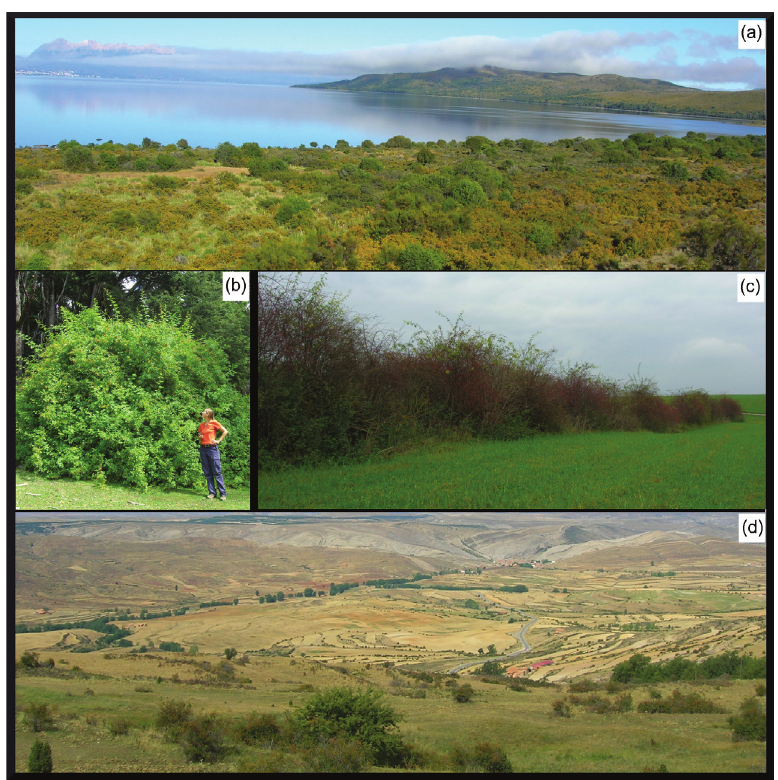
Figure 3. Invasive Rosa rubiginosa populations in Argentina (a, b) and native populations in Germany (c) and Spain (d). In parts of Argentina, single disturbance events have offered windows of opportunity for the species to establish populations, some of which have remained undisturbed for 30 years or longer ( a ) 33,39 . The low level of human landscape maintenance means that populations can expand over vast areas and consist of hundreds of individuals ( a , here along the whole visible lakeside in Patagonia). ( a ) For our study area in Patagonia we predicted that 36% of the area (5000 km 2 ) was threatened by R. rubiginosa invasion, across a precipitation gradient from 1400 mm/annum (mountains in the far background) to 600 mm/a 39 . In Argentina R. rubiginosa shrubs have time to grow to their full size ( b ), by contrast, many native landscapes are regularly maintained; shrubs are regularly trimmed and mostly grow in hedgerows ( c , Germany). Furthermore, in Germany and Spain, fewer habitats are available in landscapes dominated by agriculture and urban areas ( d , Spain) .